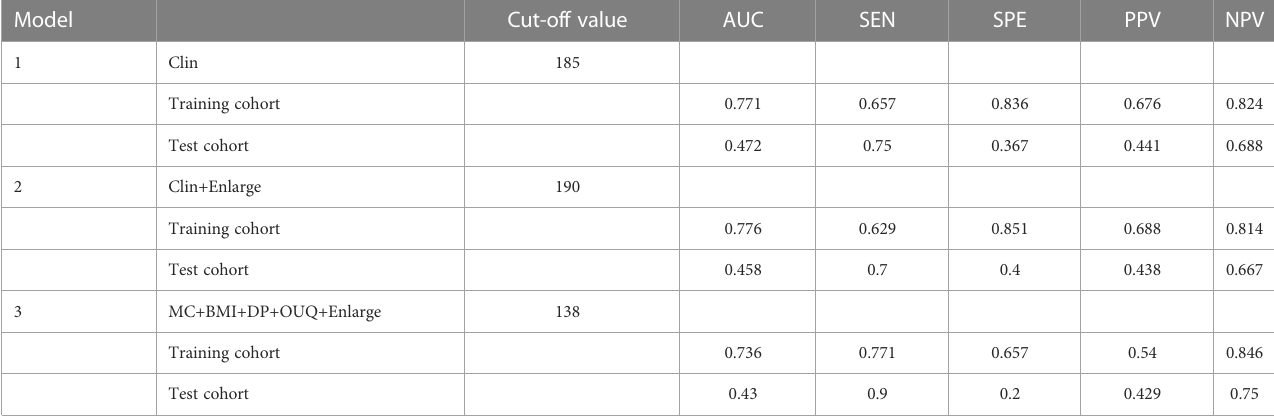
TABLE 3 Diagnostic performance of different models for predicting Her-2 overexpressing in training and test cohort.